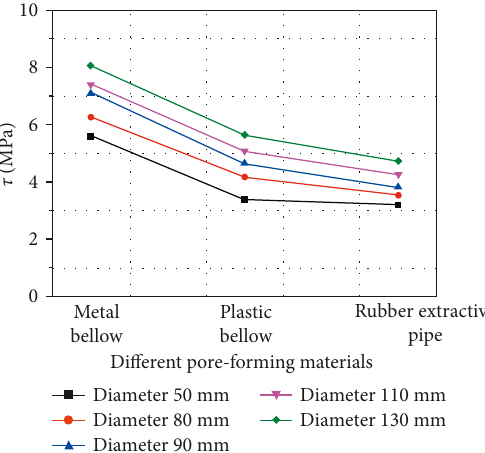
Figure 10: Relationship between the peak bond stress and pore-forming materials.